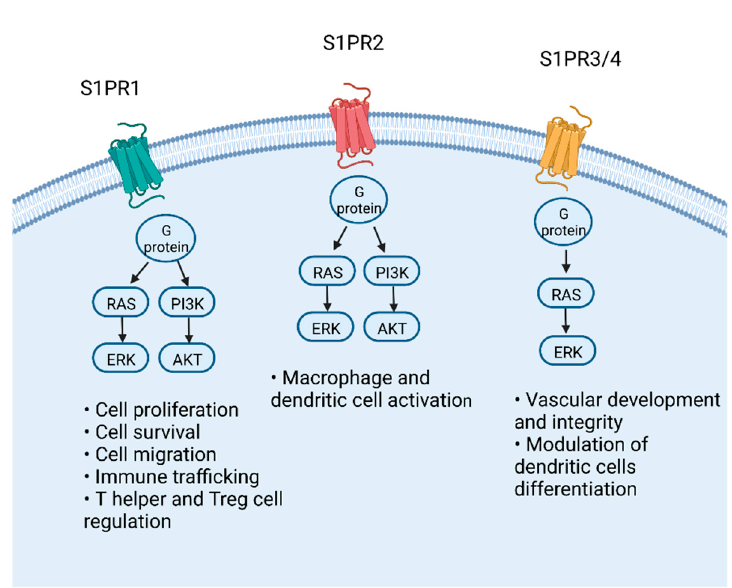
Figure 1. Cellular processes and the molecular pathway of S1P receptors.